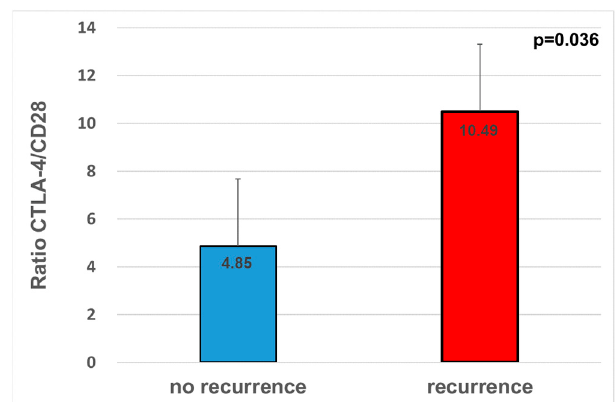
Figure 6. The ratio between CTLA-4 and CD28 was significantly higher in OSCC patients suffering from lymph node metastasis. Cases of no recurrence n = 62. Number of patients suffering from recurrence n = 25.